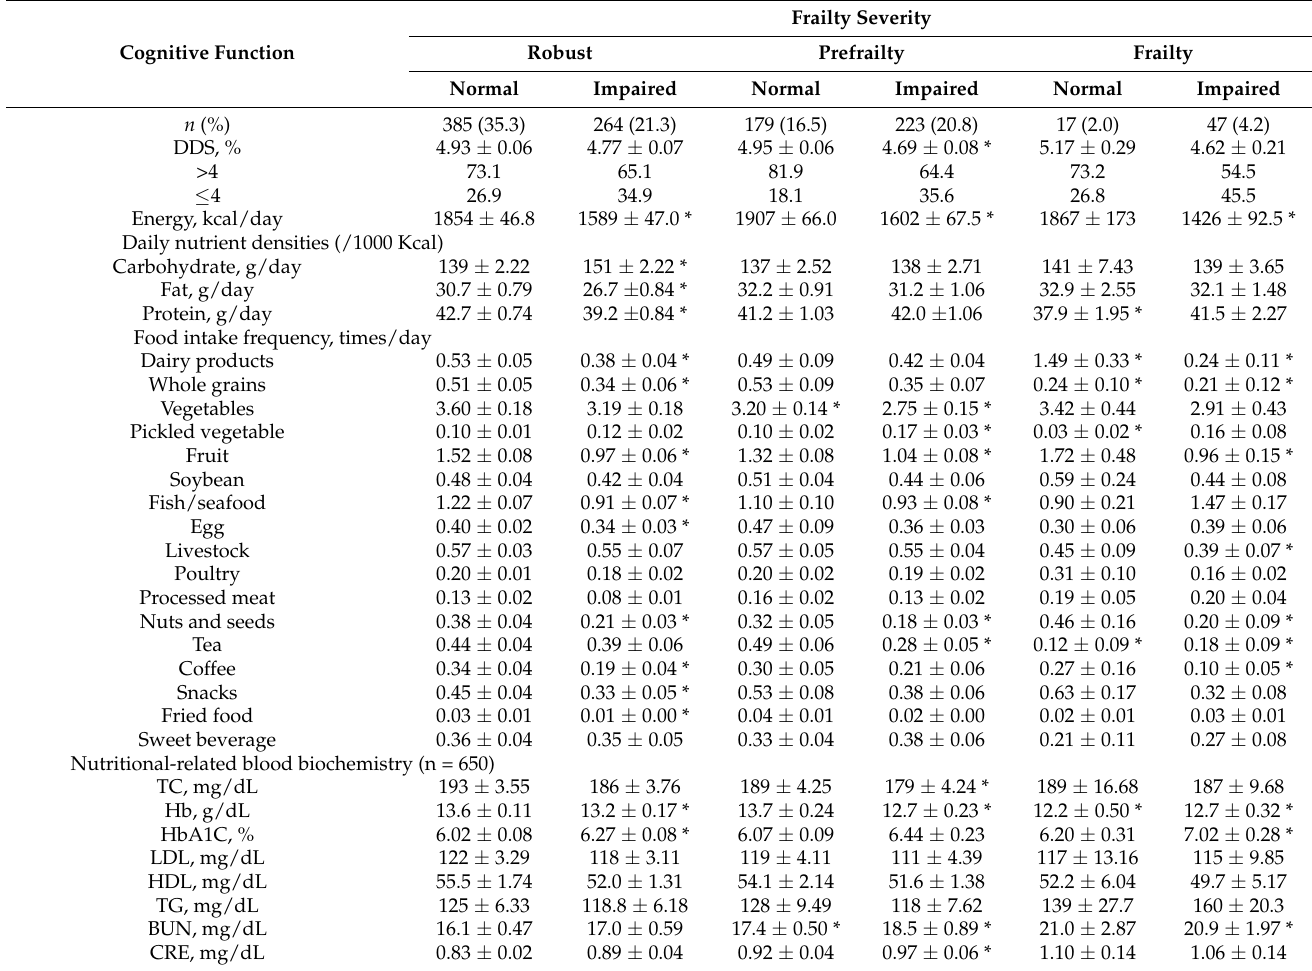
Table 2. Comparison of dietary diversity score, selected food intake, and nutritional biomarkers with frailty severity and cognitive function in older adults in the 2014–2016 Nutrition and Health Survey in